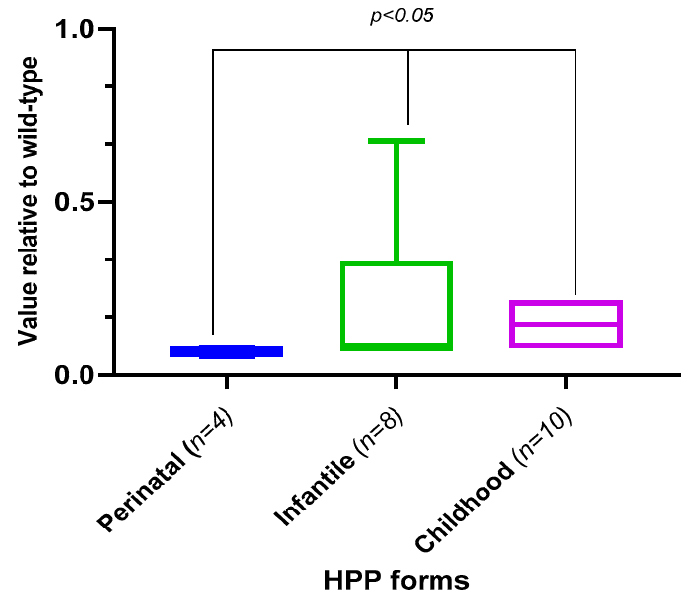
Figure 11. Residual activity of TNSALP variants relative to their wild-type, according to HPP subtype [21].